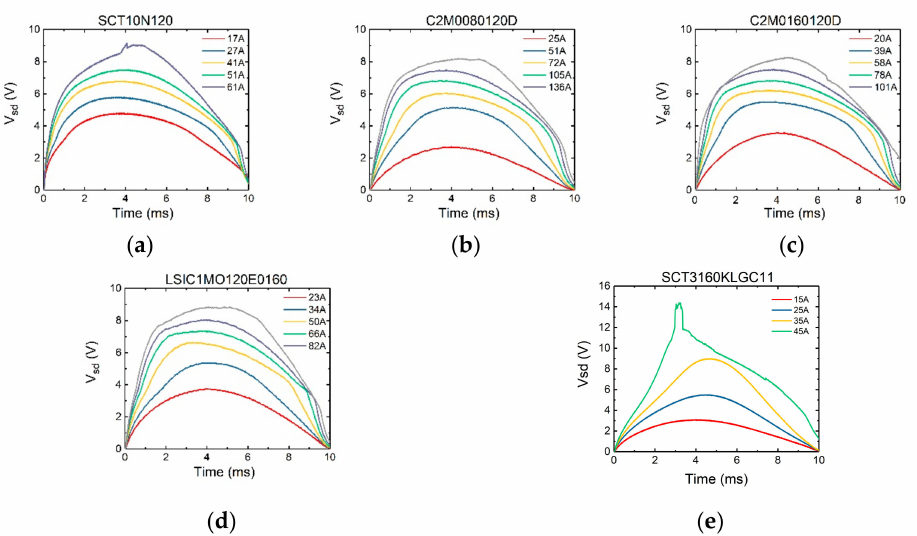
Figure 5. The variation of voltage V sd of ( a ) SCT10N20, ( b ) C2M0080120D, ( c ) C2M0160120D, ( d ) LSIC1MO120E0160, ( e ) SCT3160KLGC11 SiC MOSFETs when varying surge current amplitude with V gs = 10 V.